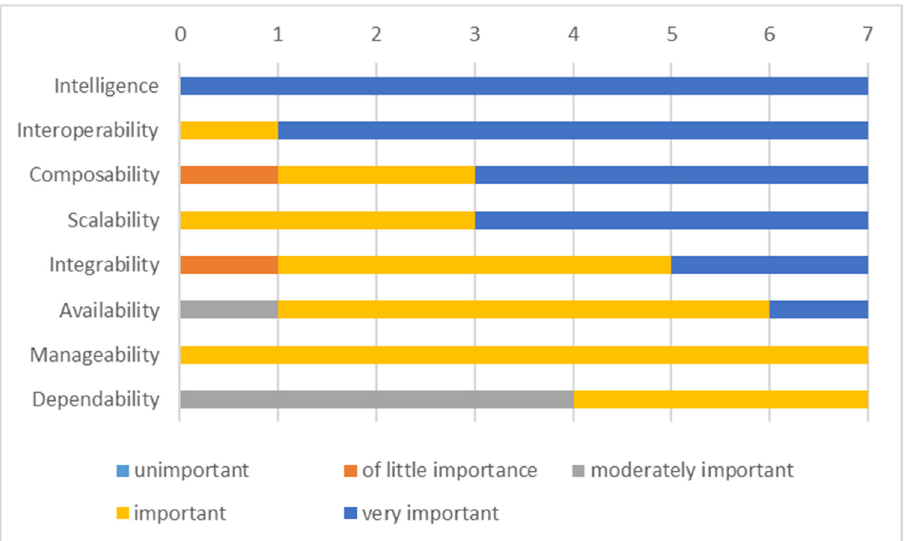
Figure 9. CREATE-IoT RAM properties-based classification summary.